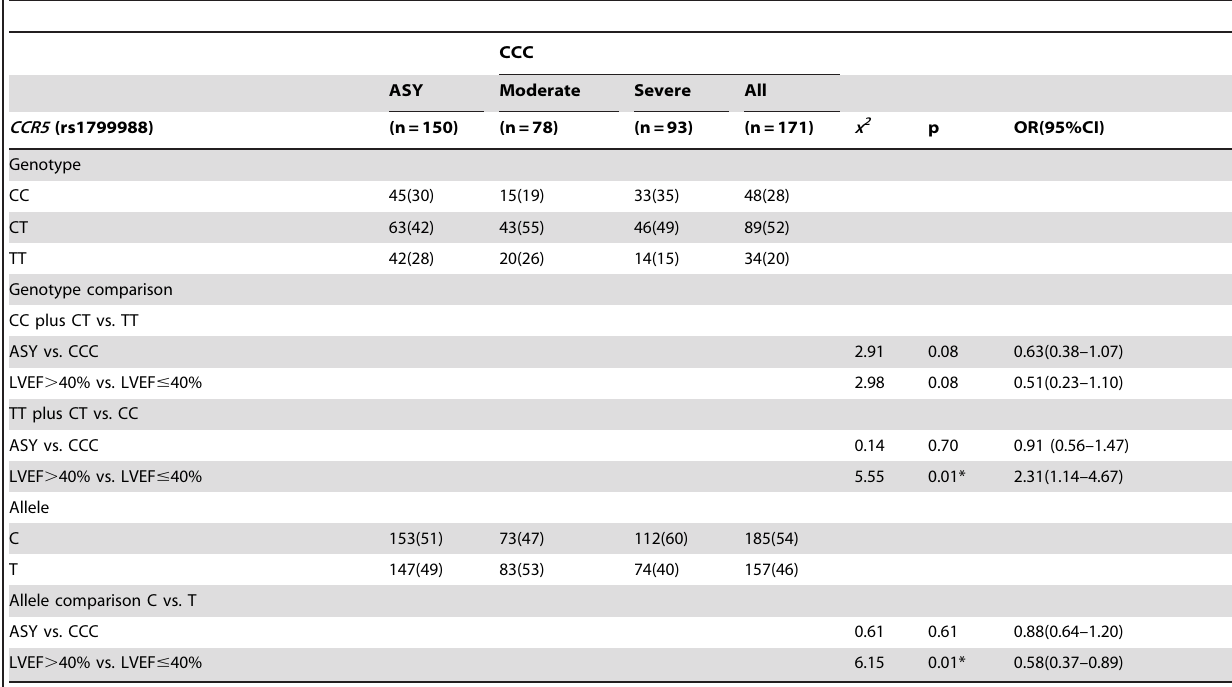
Table 4. Genotype and allele frequencies for the CCR5 rs1799988 polymorphism in patients with Chagas disease.